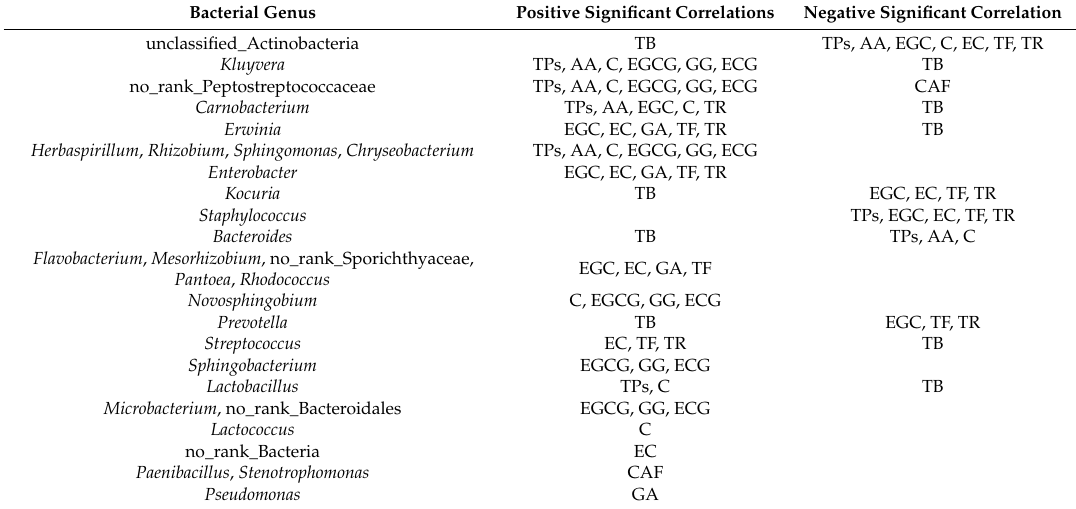
Table 4. Summary of the significant correlation coefficients between bacterial genus and the tea’s chemical compounds.